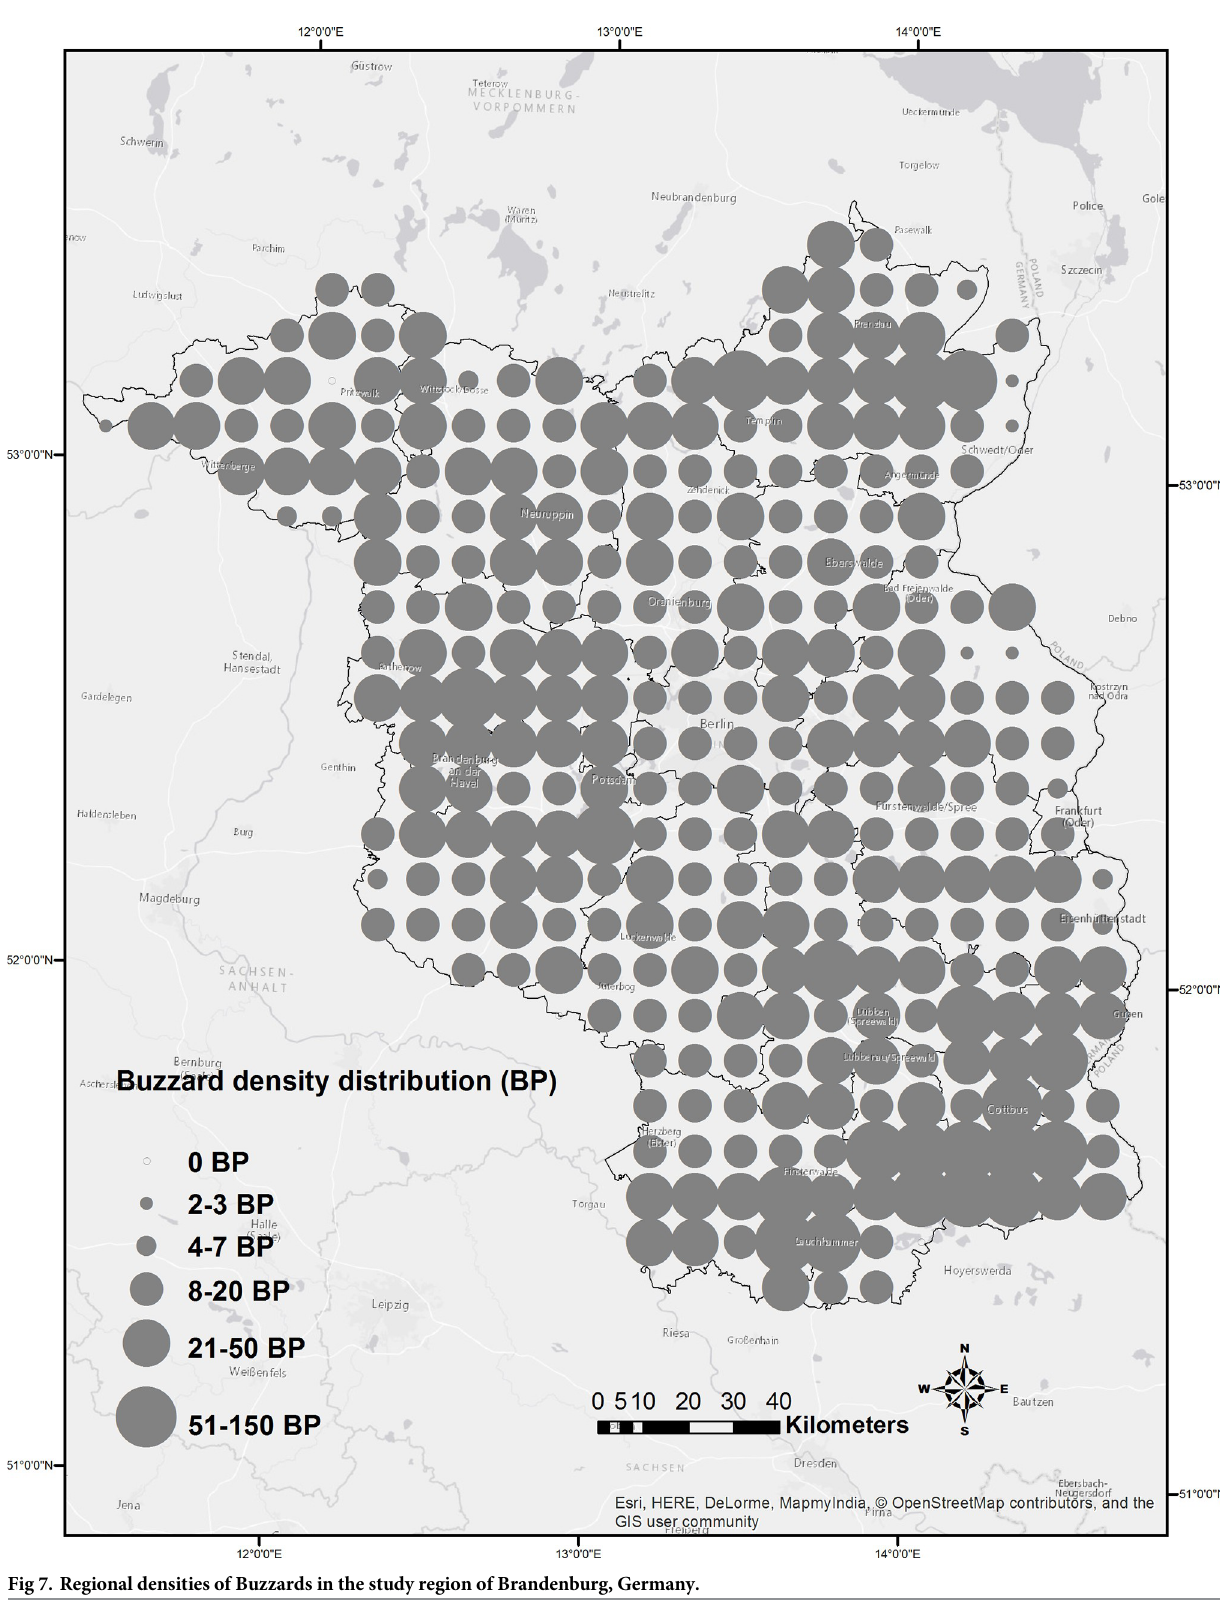
PLOS ONE | https://doi.org/10.1371/journal.pone.0227698 January 24,